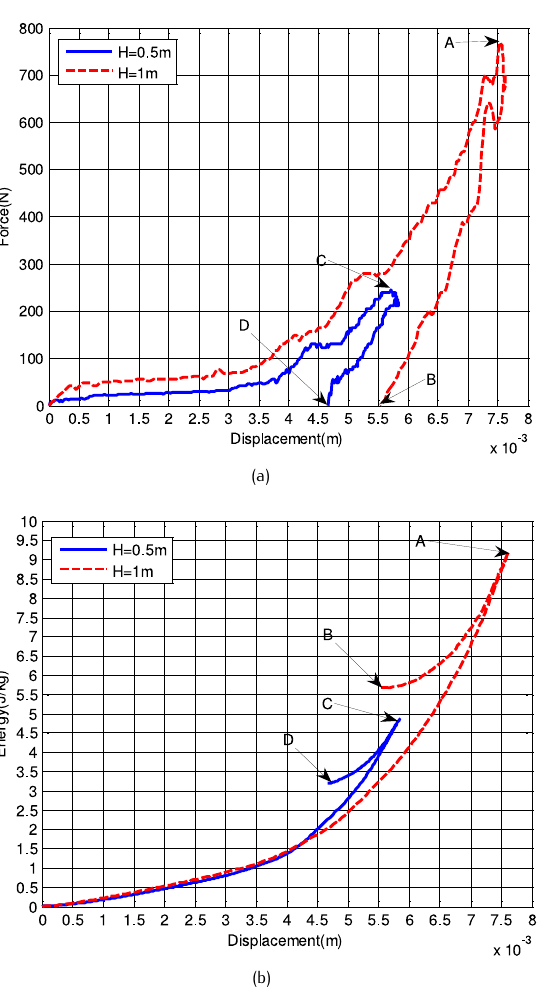
Figure 11. Crushable PUR foam in two drop heights (a): Contact force versus displacement (b): Absorbing energy versus displacement.